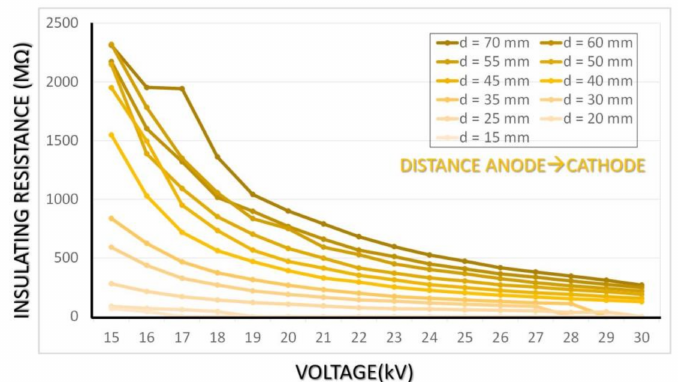
Figure 17. Single thruster (400 mm electrodes): air insulating resistance vs. voltage for different distances between cathode and